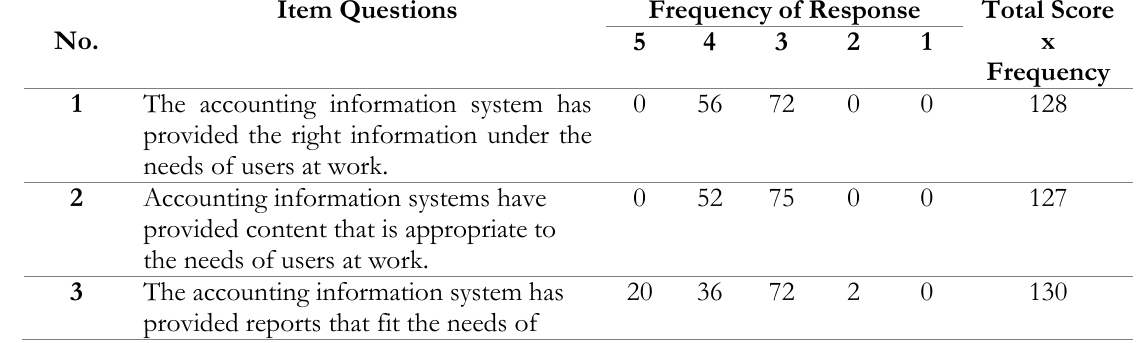
Frequency Distribution of Respondent Responses Application of Accounting Information